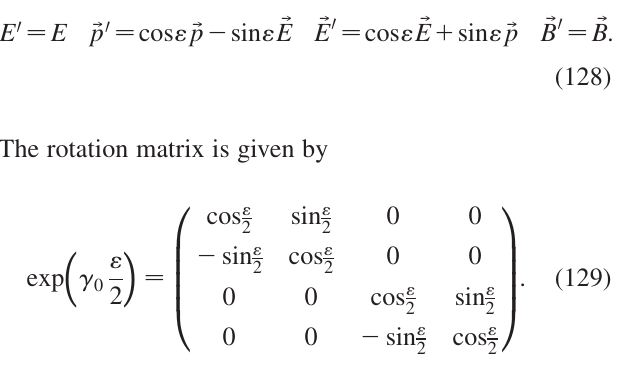
, (cid:1) , (cid:1) , (cid:1) form an 0 4 5 6 , (cid:1) , (cid:1) , (cid:1) . The phase rotation 0 1 2 3 changes the ‘‘mixing’’ angle of the stan- 0